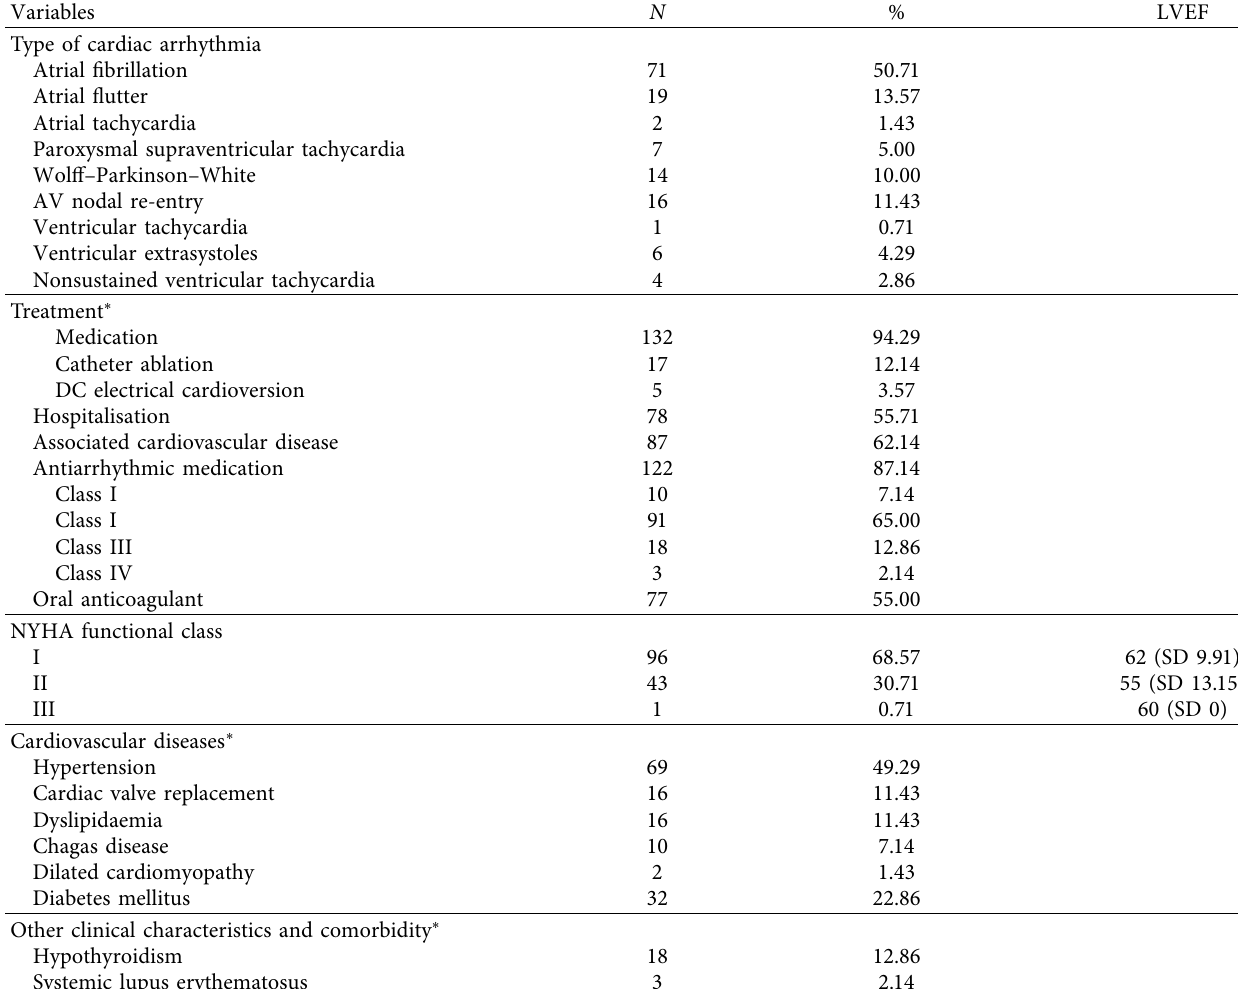
Table 1: Clinical characteristics of the participants ( n �